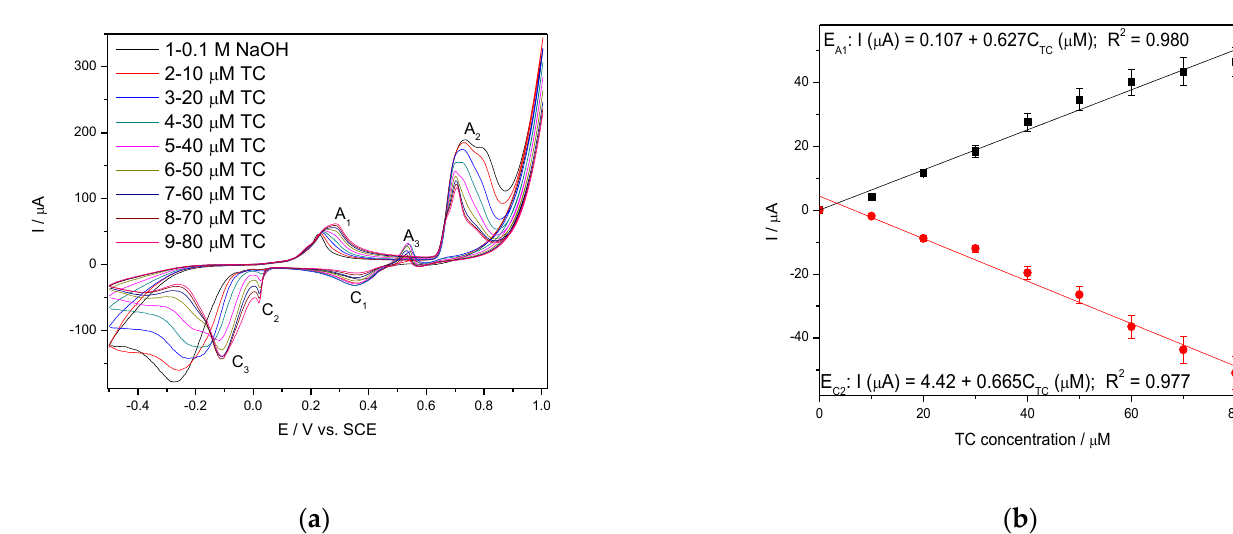
( b ) Figure 7. ( a ) CVs recorded at 0.050 V·s − 1 scan rate on BDD/GO/Ag in 0.1 M Na 2 SO 4 supporting electrolyte and in the pres- ence of various TC concentrations: 2-16 µM TC; potential range: − 0.500 to +1.00 V/SCE; ( b ) Calibration plots of the currents recorded at E 1 = +0.550 V/SCE and E 2 = +0.850 V/SCE vs. TC concentrations. In according with [27], TC oxidation occurred in two steps based on two electrons involvedat each step (Equations (5) and (6)).